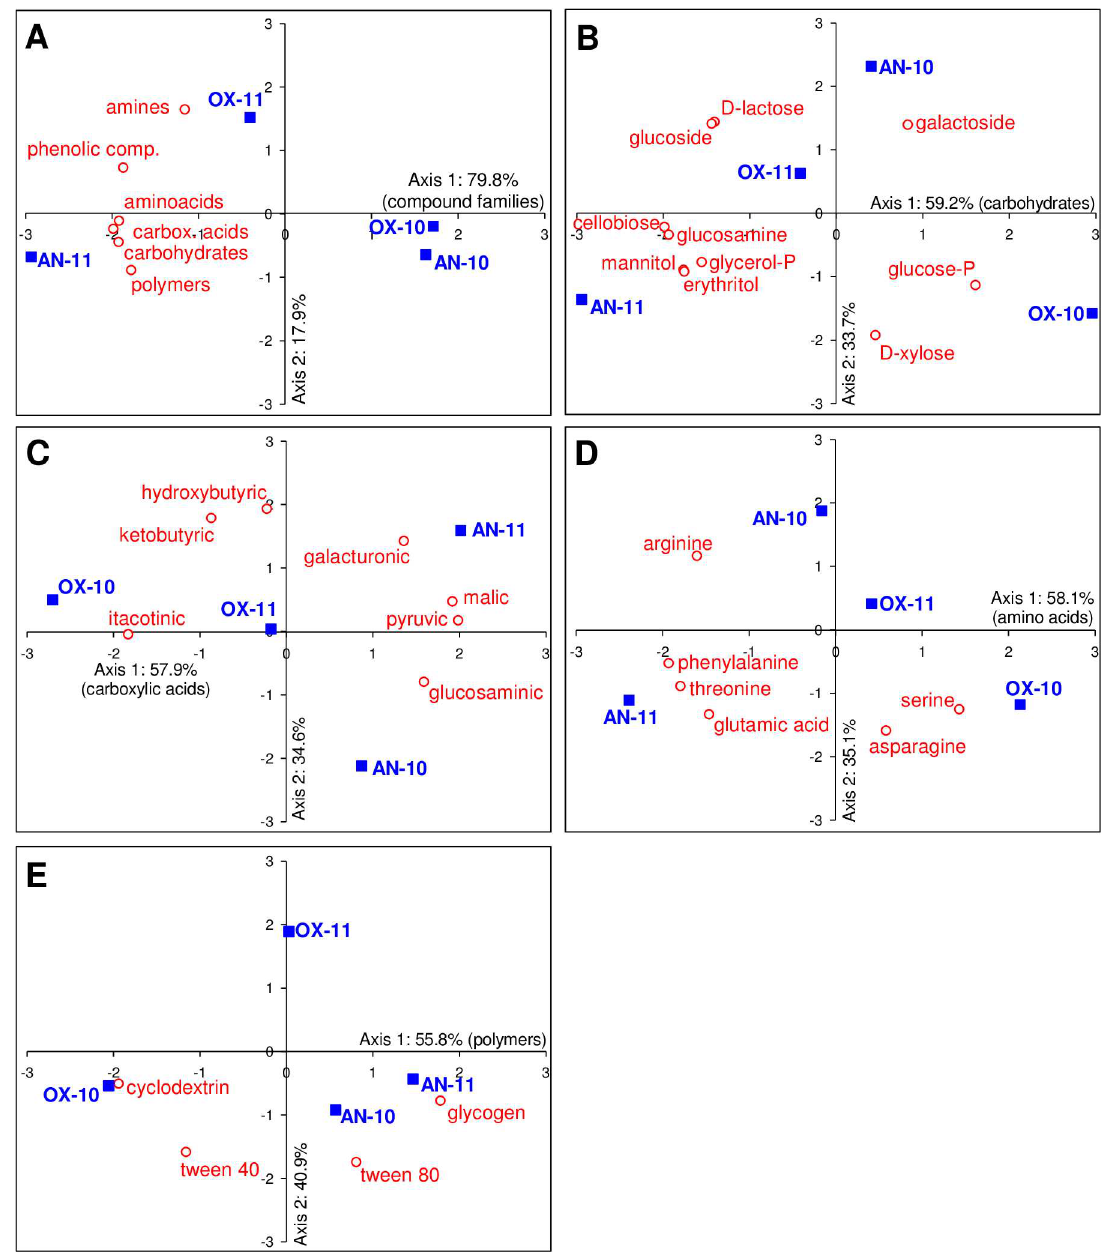
Fig 8. Principal component analysis (PCA) of Biolog ECO plates community metabolic potential. AWCD after 96 h incubation was used as input data. Samples are representedby blue squares, with OX and AN for oxic and anoxic conditions respectively, with samplingyear provided. PCA were performed for compoundmerged(A) in families, or moleculeswithin a chemicalgroup: (B) carbohydrates, (C) carboxylicacids, (D) amino acids, and (E)